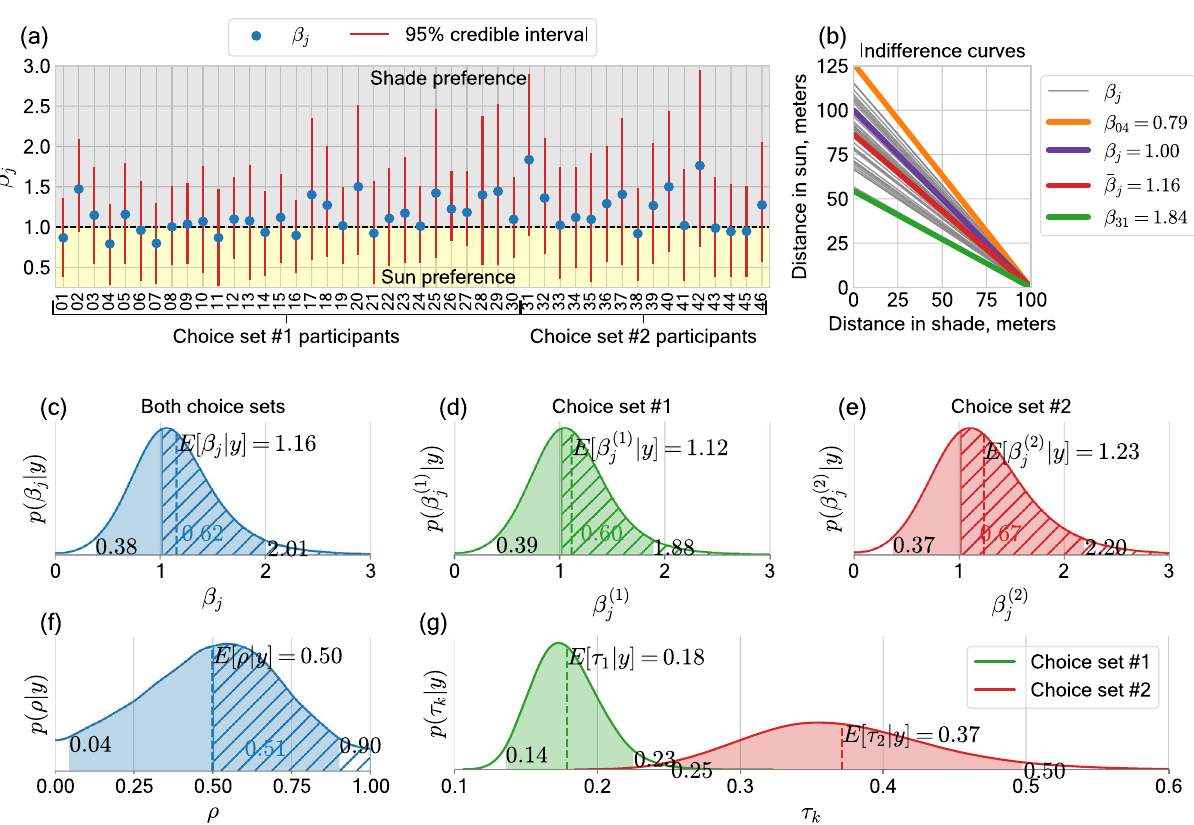
Figure 3. Estimated parameters of the hierarchical model of path choices. (a) The expected value and 95% credible interval of participant-specific distance-inflating coefficient of the sun β j . β j > 1 means preference towards shade in the process of path choice. (b) The distance inflating coefficient of the sun regulates the slope of the curve of indifference between distance walked in sun and distance walked in shade. Indifference curves of individual participants are shown in grey. β j = 1 corresponds to complete indifference, whereas corresponds to the average value of the coefficient estimated from the path choices of all participants. On average participants were indifferent between walking 100 m in full shade, 93 m of mixed exposure (50 m in full shade + 43 m in the sun) and 86 m in the sun. (c) The posterior distribution of the distance-inflating coefficient of the sun for path choices pooled for all participants, participants with choice set #1 (d) and choice set #2 (e) . 95% credible intervals are depicted as filled regions. Hatched regions correspond to the mass of the posterior distribution over β j > 1 . (f) The posterior distribution of the perceived tree shade intensity ρ ; the expected value of 0.50 implies that, on average, tree shade is perceived as 50% as intense as the building shade. (g) Posterior distributions of cost-difference scaling parameters τ k . The disjoint 95% intervals of the two distributions can be explained by a different overall length of path options in the two choice sets. The figure is generated with use of package matplotlib v3.2.2 (https:// matpl otlib. org/) for Python